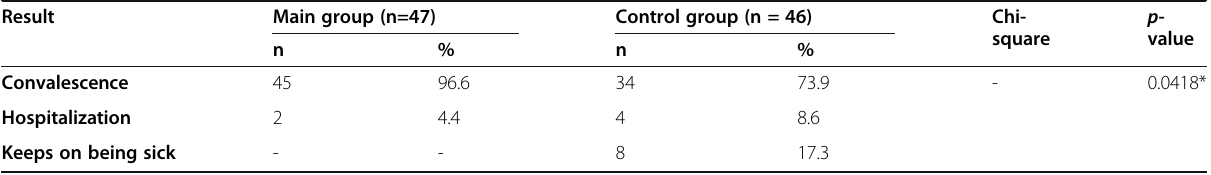
Table 6 Group analysis by treatment